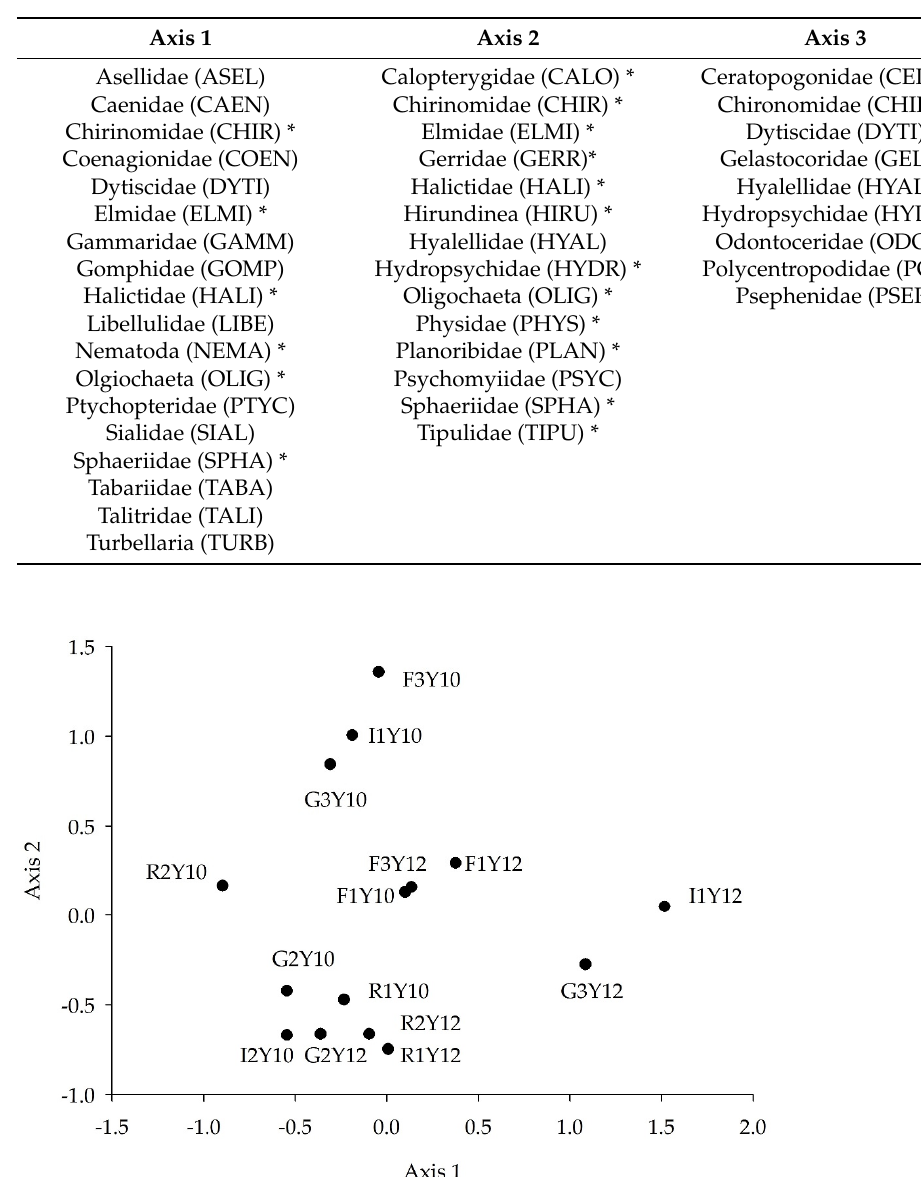
Table 5. List of freshwater invertebrates collected in the Neponset River Watershed and its associated axes for non-metric multidimensional scaling. Organisms with * have higher tolerance to poor water quality conditions based on Hilsenhoff [27].